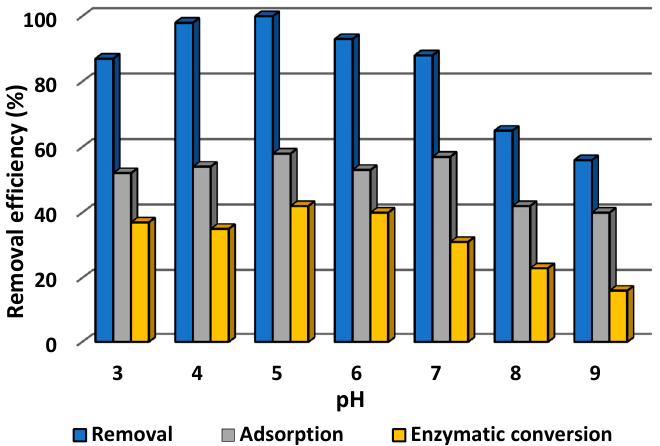
Figure 7. Effect of pH of tetracycline solution on the efficiency of its adsorption, enzymatic conversion, and total removal by laccase immobilized on a chitinous scaffold. The error value in each of the experiments (based on the mean and standard deviation from three experiments) does not exceed 3.5%. Adsorption efficiency denotes the efficiency of adsorption by the chitinous scaffolds with immobilized laccase following thermal inactivation.